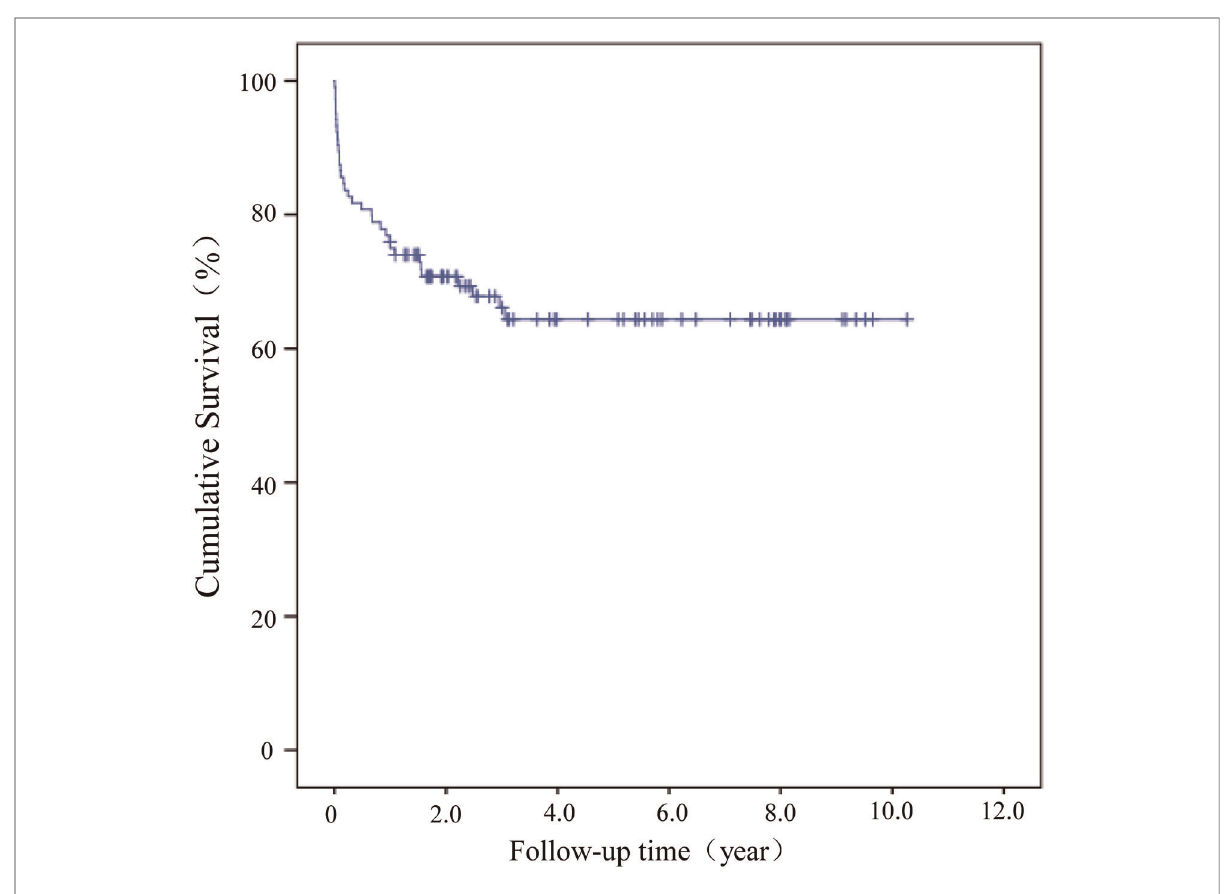
FIGURE 1 Kaplan – Meier (KM) survival analysis for the cohort of patients who underwent a DAIR procedure failure was de fi ned as the